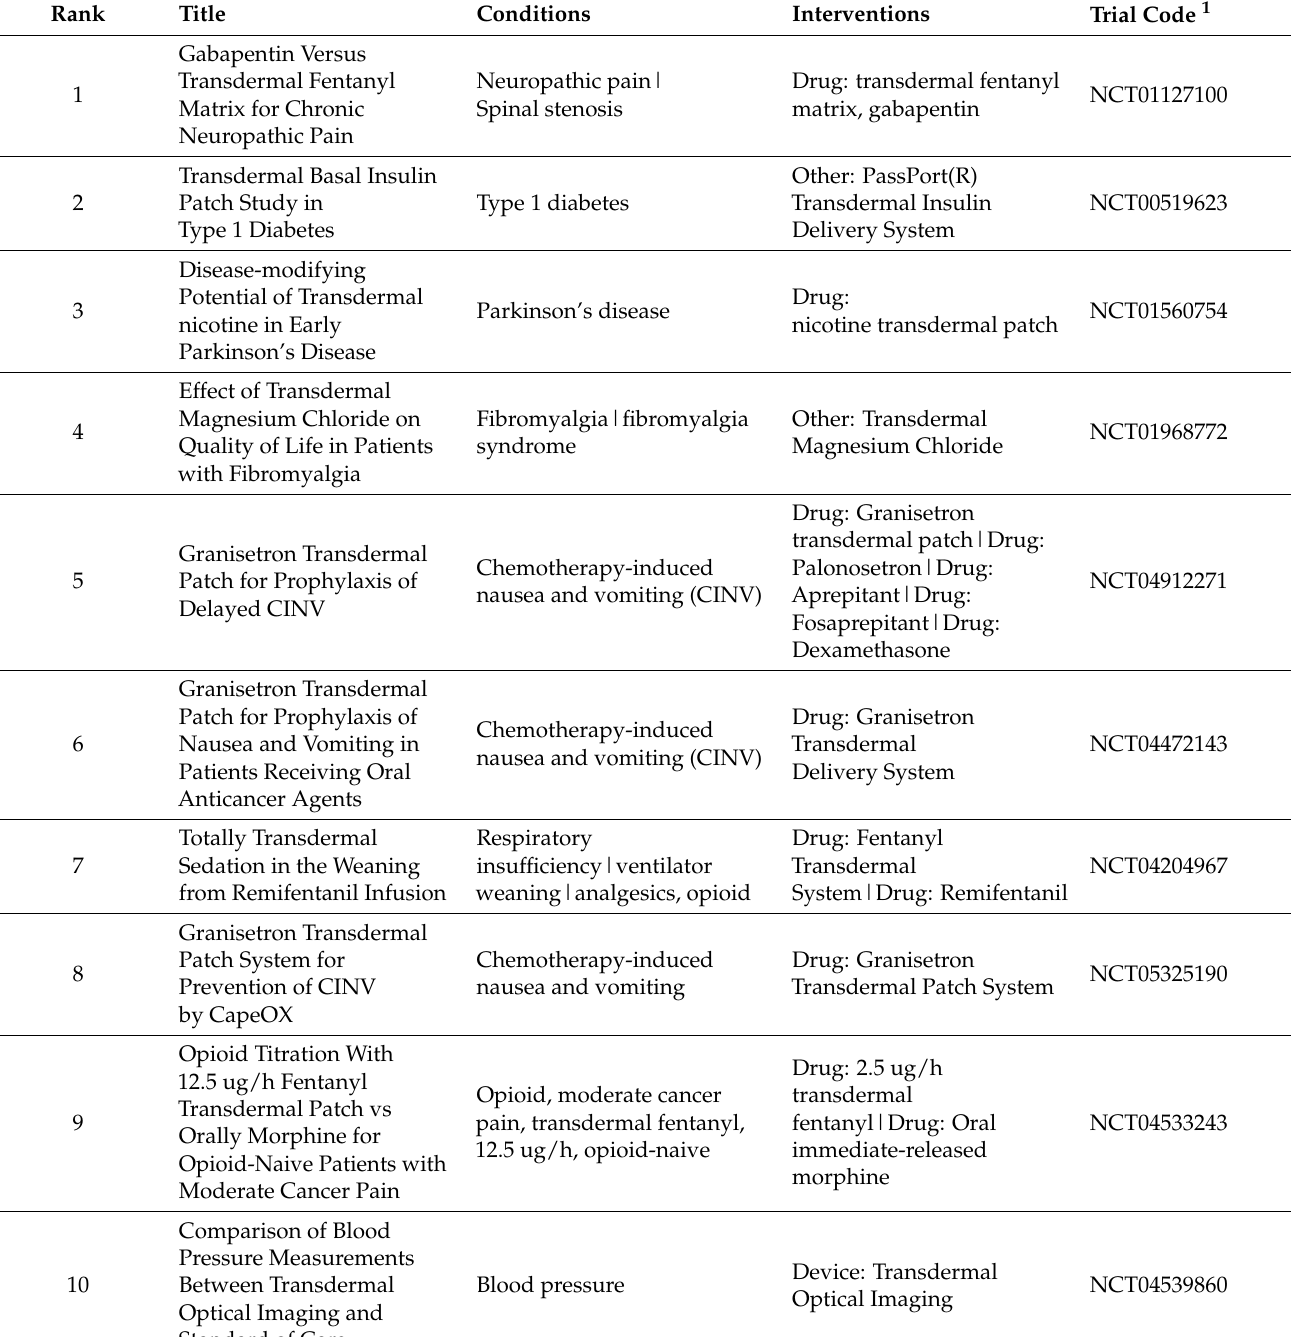
Table 4. Recent clinical trials investigating transdermal delivery systems. 1 Full clinical trial informa- tion can be accessed via a trial code by searching for the trial code/reference [330]. Data presented in this table is publically available and open access via https://ClinicalTrials.gov/ (accessed on 15 April